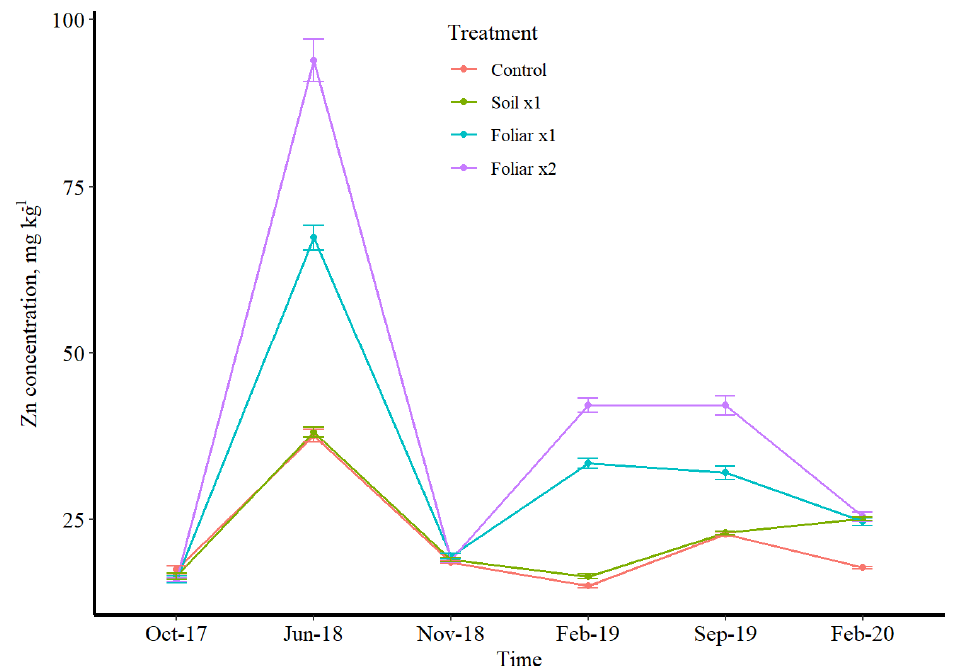
Figure 3. Zn leaf concentration over time in different micronutrient treatments (control, soil ×1. foliar ×1, and foliar ×2). B, Mn, and Zn rates were 1.12, 10.08, and 5.60 kg ha − 1 . Lines represent data with 95% confidence intervals.